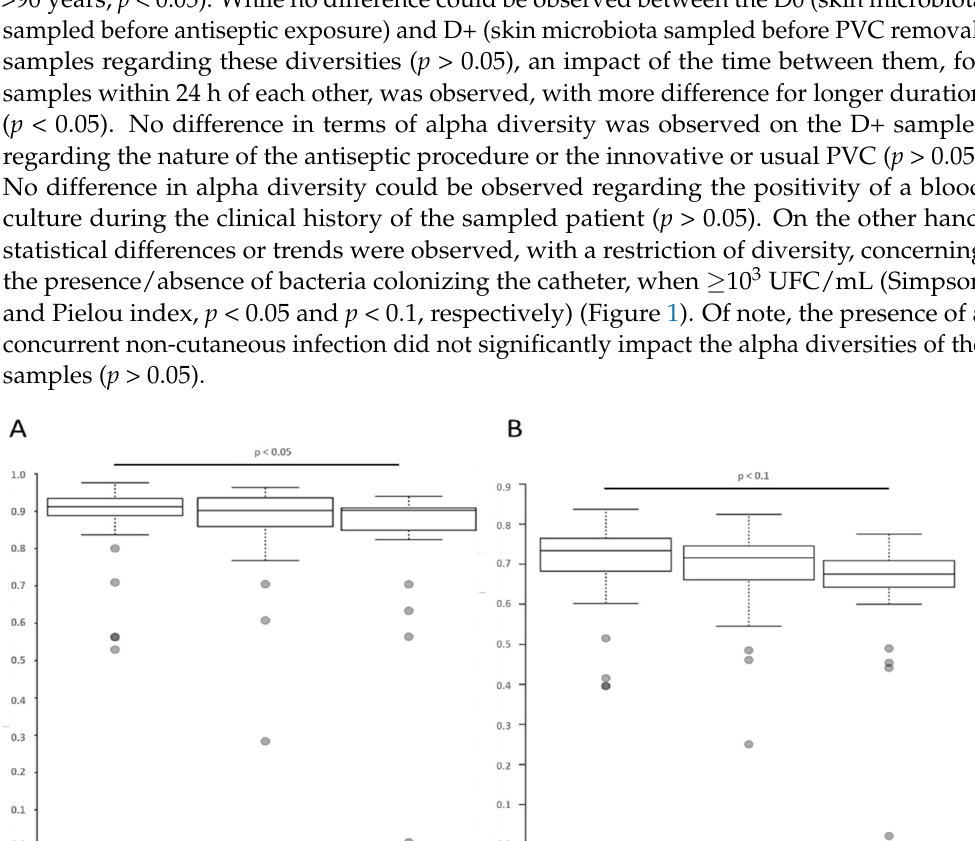
Figure 2. Comparison of beta-diversities, determined with different indexes (Bray Curtis Indexes, ( A – C ); and Jaccard indexes, ( D – F )) according to the nature of the sample (D0 or D+; ( A , D )) or re- sults of the PVC ( B , E ) and blood cultures ( C , F ). *: p < 0.05; **: p < 0.01; D0: initial sample; D+: abla- tion sample. The box plots represent the mean and interquartile range for each permutation, and the vertical axis represents the distance between groups. Although microbiota composition analysis did not predict clinical outcome or therapeutic management, all parameters showed a difference in the respective propor- tions of certain bacteria. Initially, the parameter of age was associated with an